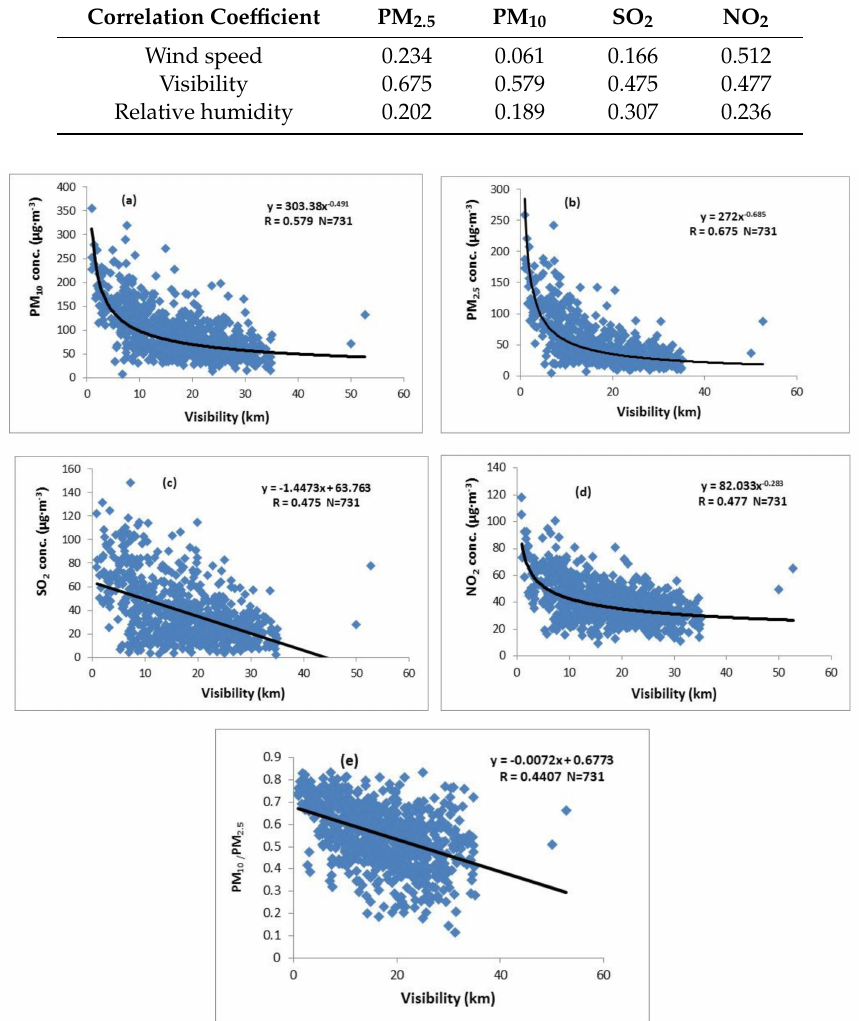
Figure 5. Scatter plots of mean daily ( a ) PM 10 , ( b ) PM 2.5 , ( c ) SO 2 , ( d ) NO 2 , and ( e ) PM (PM 10 and PM 2.5 ) concentrations and visibility recorded at the Hunnandonglu meteorological station in Shenyang from 1 January 2016 to 31 December